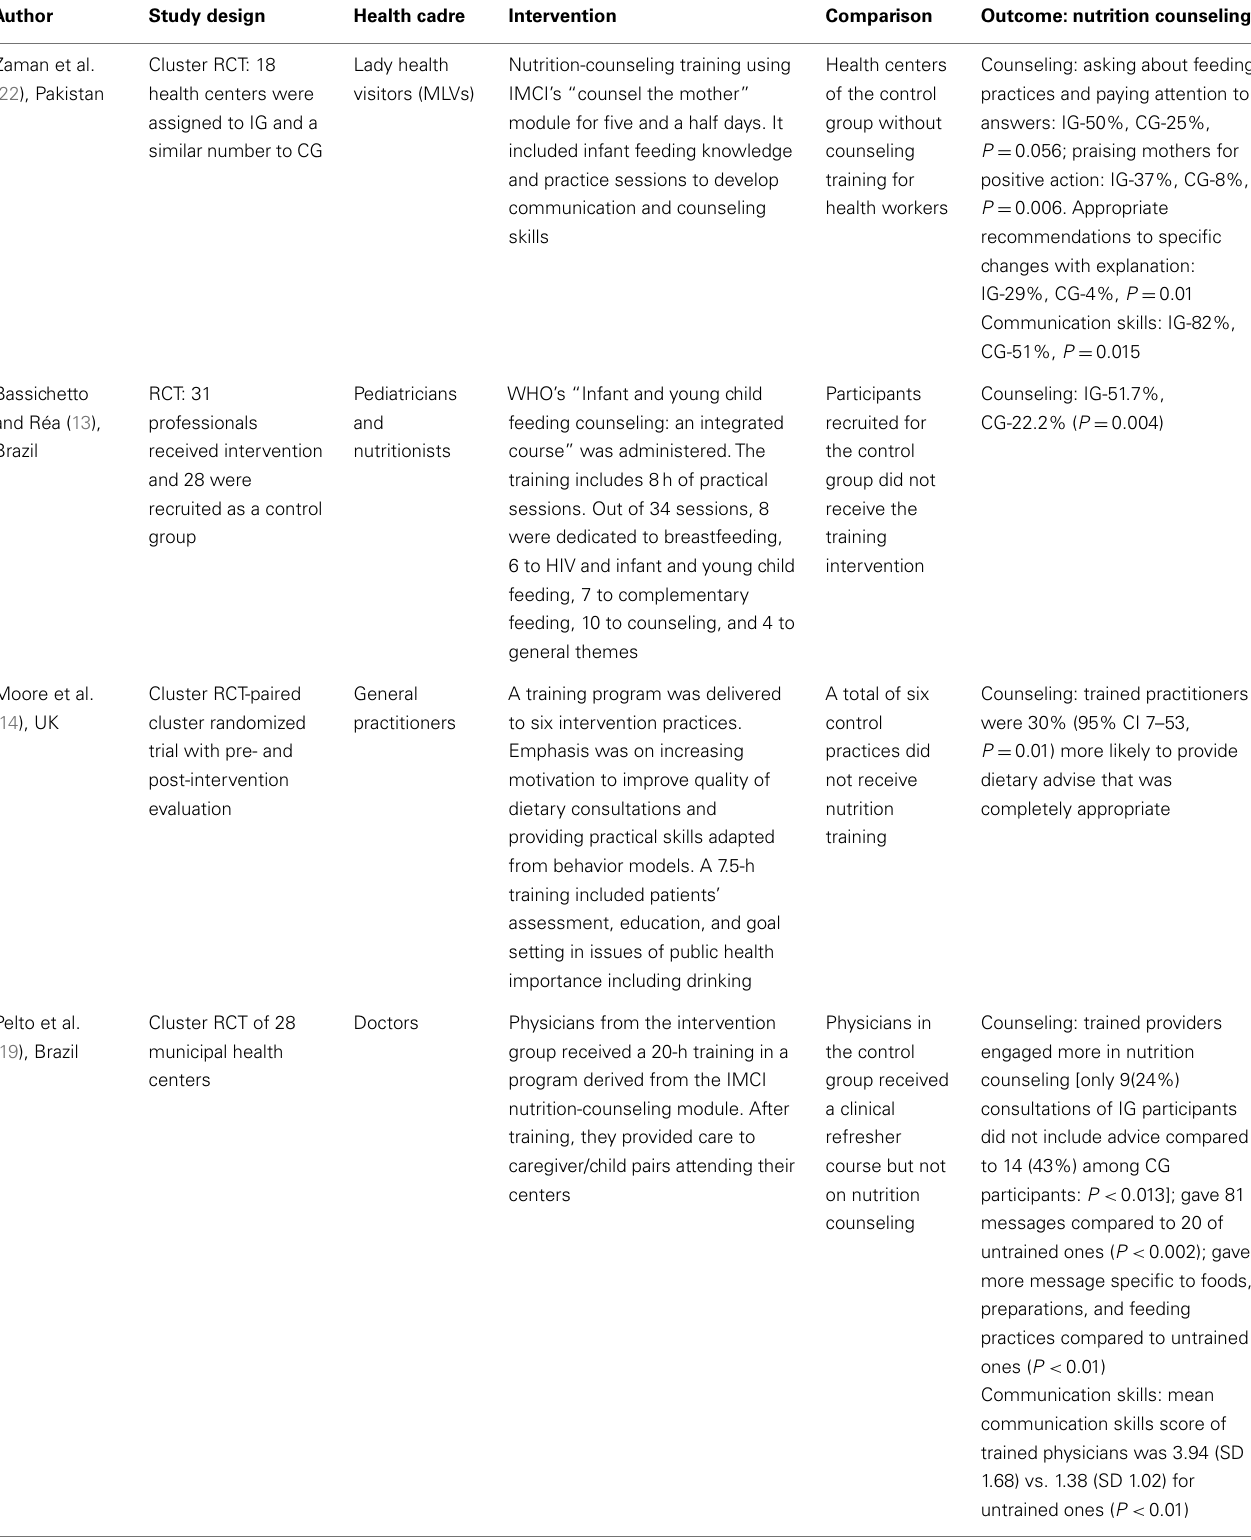
Table 6 | Effectiveness of nutrition training to improve nutrition counseling and counseling skills of